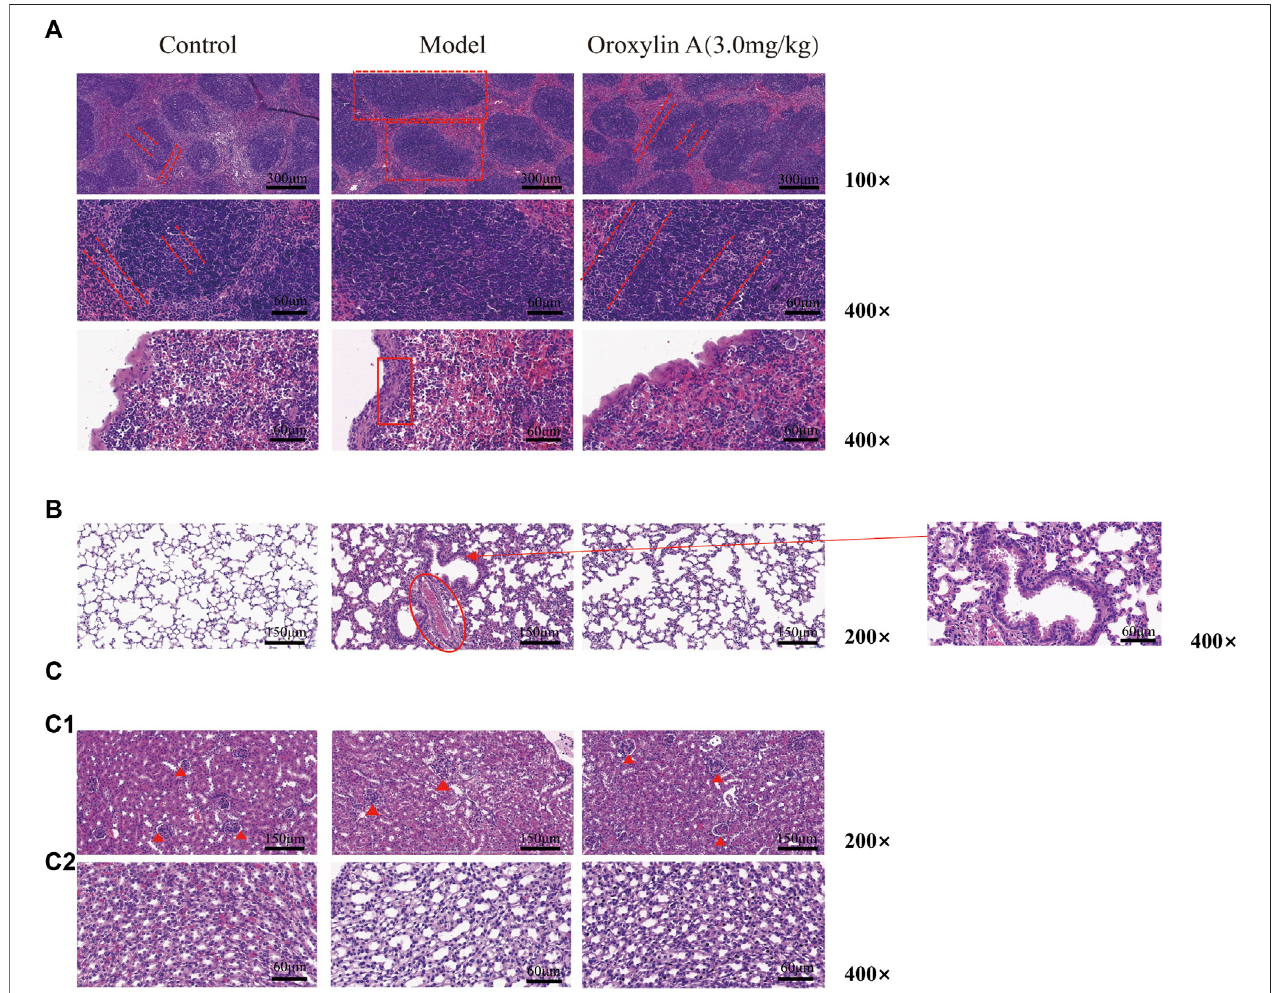
FIGURE 5 | Organ protection of oroxylin A on LPS-induced endotoxemia mice. H&E-stained spleen (A) , lung (B) , and kidney (C) sections of control, model, and treatmentgroups.Oroxylin Awas30 minpriortotheinjectionofLPS(30 mg/kg,iv).Tissueswerecollectedaftertreatmentfor24 h.Thenumberofmiceineachgroupis greater than or equal to